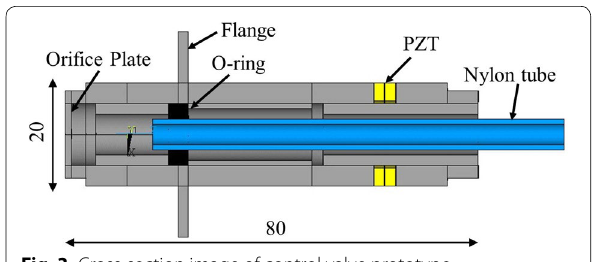
Fig. 3 Cross-section image of control valve